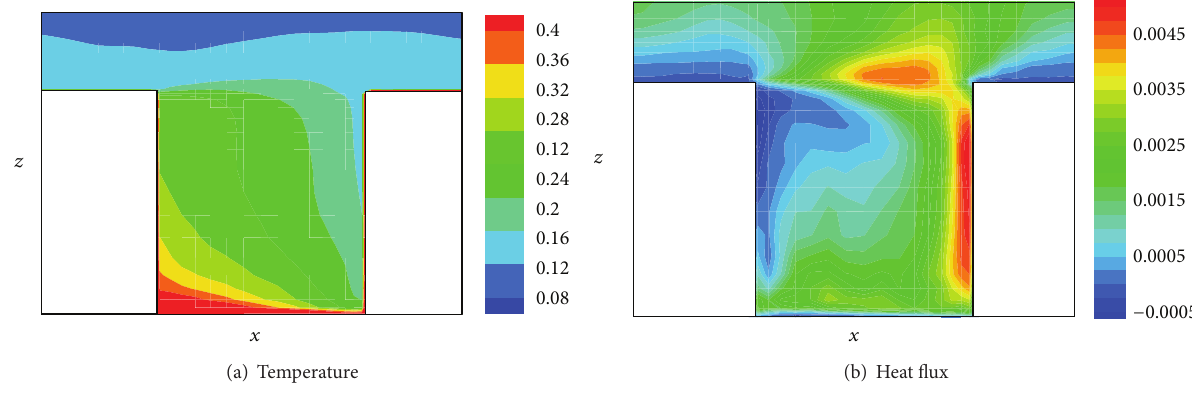
Figure 11: Contours of normalized mean temperature (Θ−Θ 𝑓 )/(Θ 𝑔 −Θ 𝑓 ) and normalized turbulent heat flux 𝑤 󸀠󸀠 𝜃 󸀠󸀠 on vertical plane through the middle of